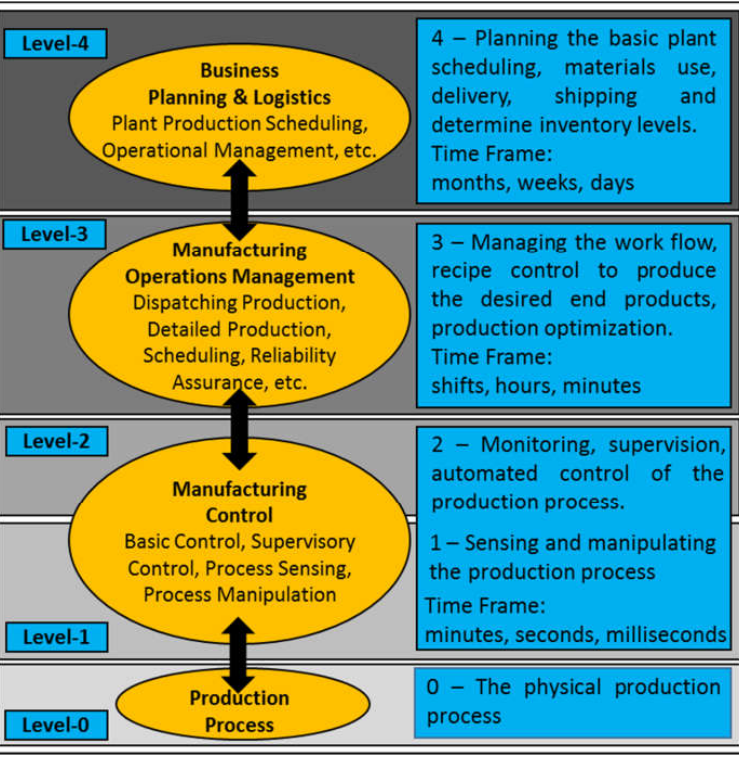
Figure 3. ANSI/ISA-95 Standard Architecture.